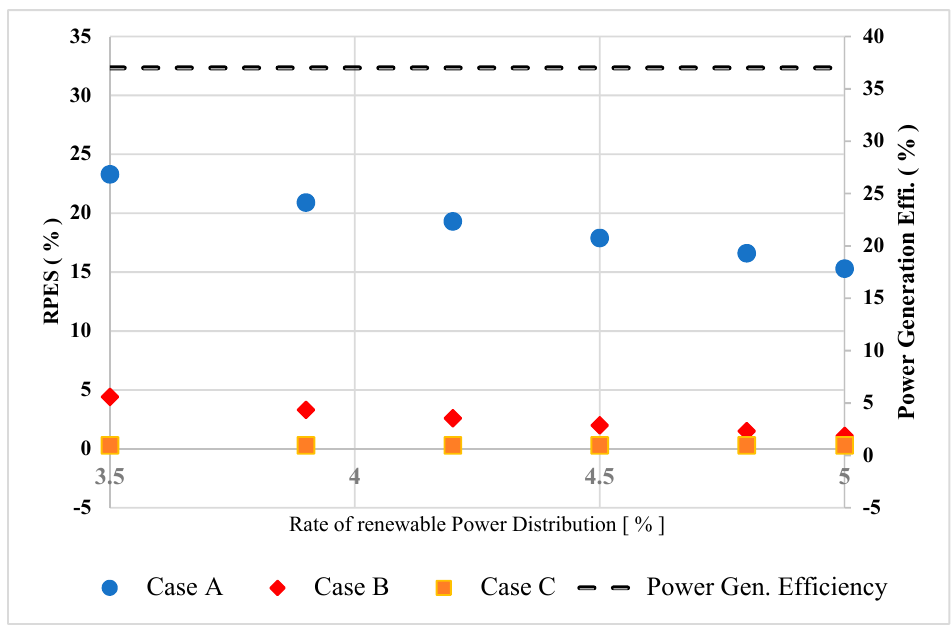
Figure 22. RPES performance of TSG against SHP according to the development of heat pump operational performance.